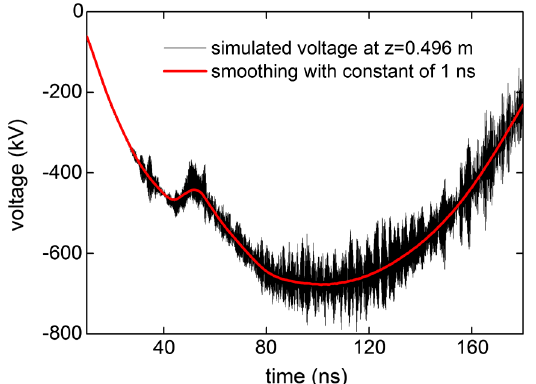
FIG. 10. Simulated MITL voltage at z ¼ 0 : 496 m , where hel- ical support was placed. The black line represents signal by integrating the absolute electric field across the A-K gap. The red line denotes average smoothing to adjacent points with 1 ns constant. The maximum of the red line is 718